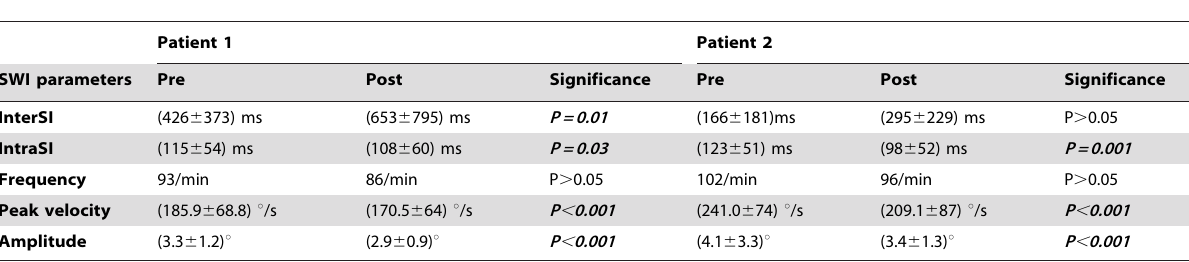
Table 2. Main SWI parameters (data of both patients are showed).